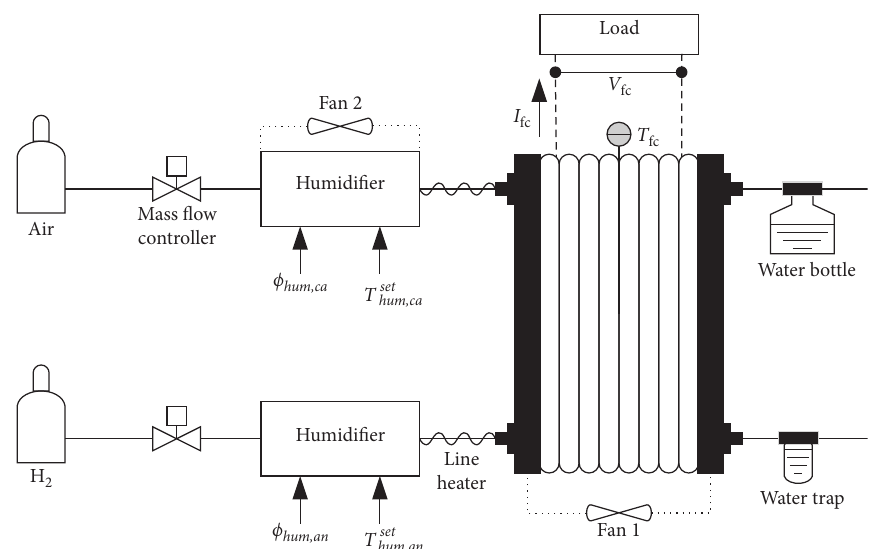
Figure 1: Schematic diagram of a PEMFC stack and the PEMFC system.